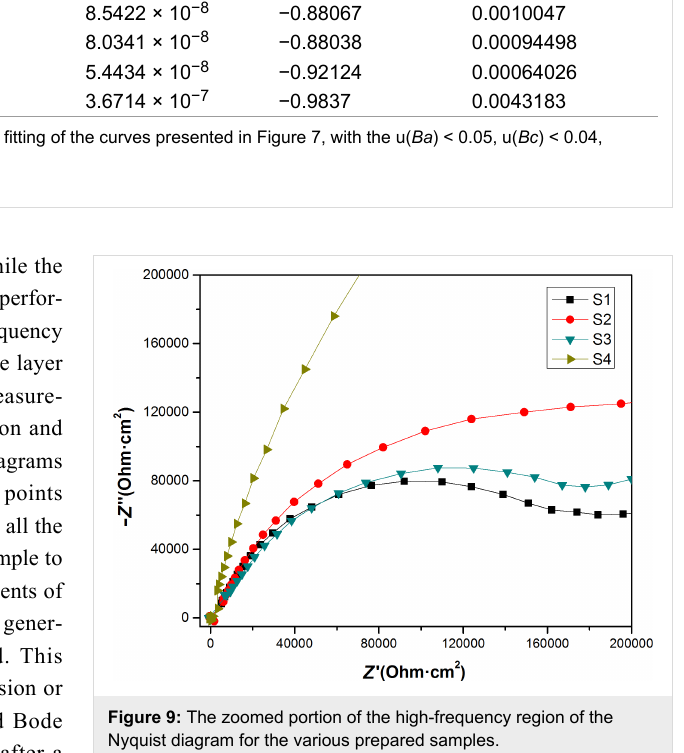
layer capacitance deviating from an ideal capacitance. The ele- ment with the capacitance C parallel to R 1 designates the porous layer of the AAO film, while the other element with constant phase angle element parallel to R 2 refers to the imped- ance layer in the AAO film. R 2 represents the interfacial resis- tance of each blocking layer. The R 2 values are presented for